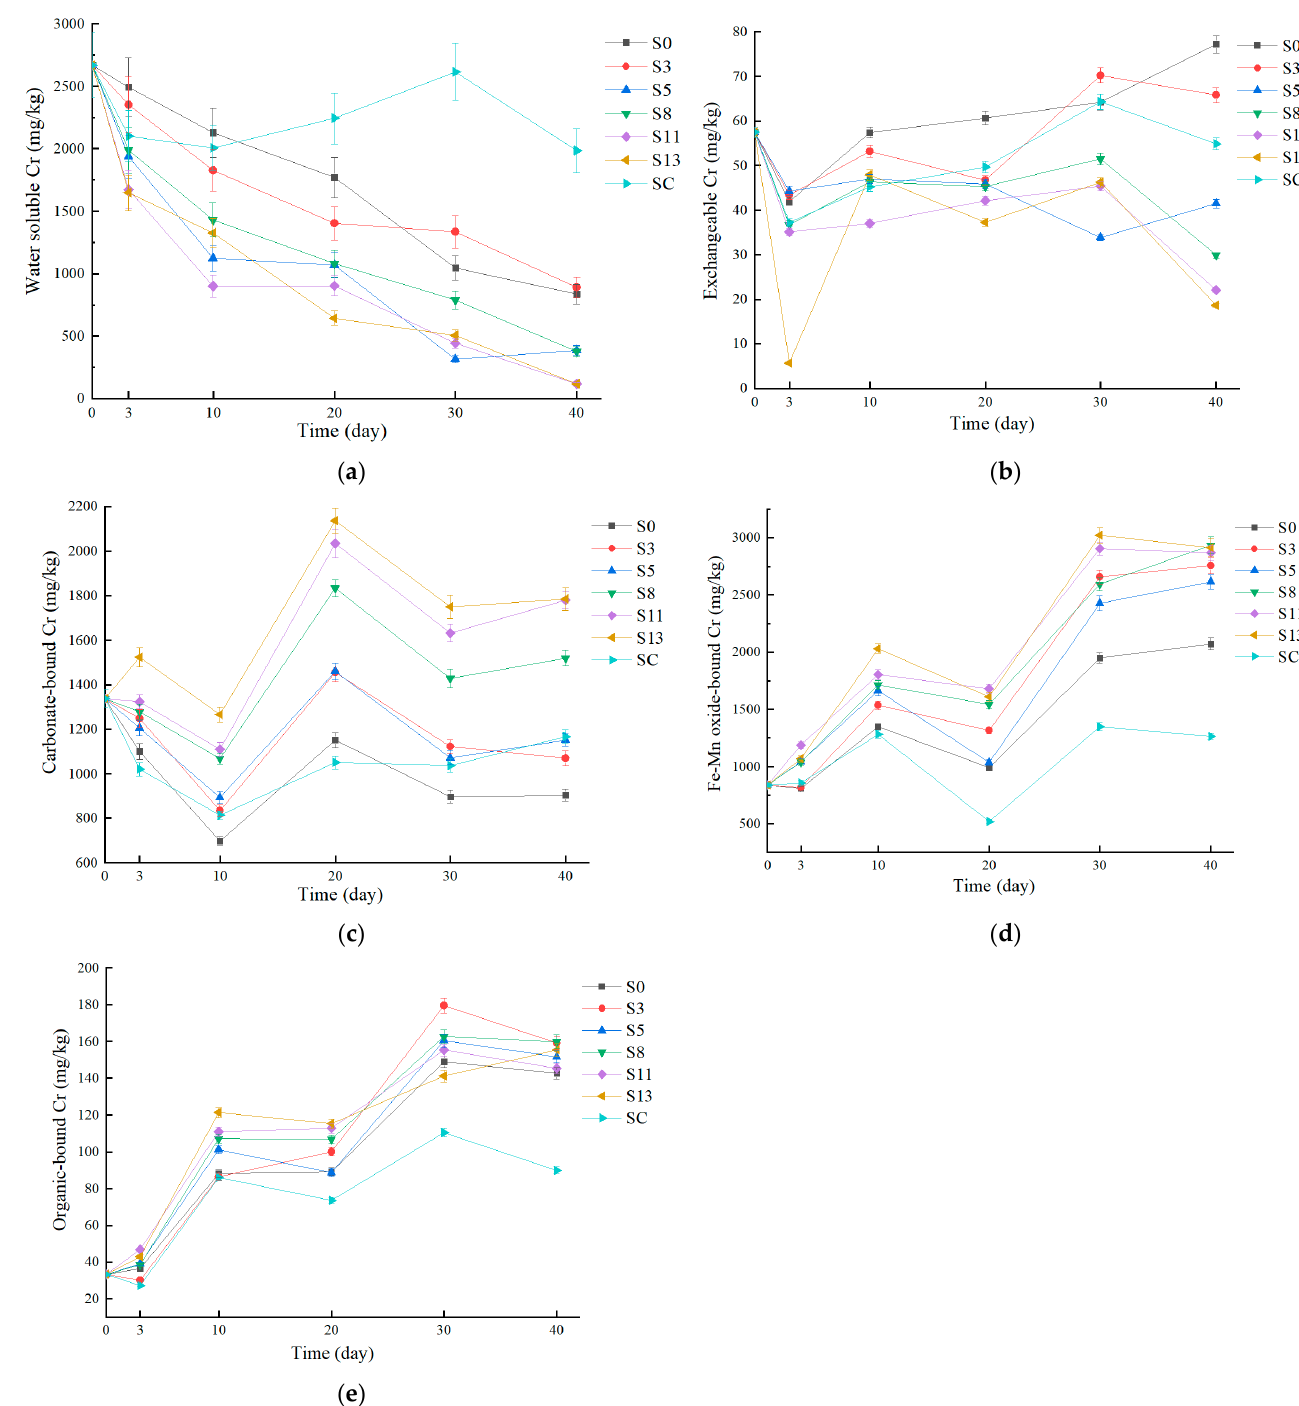
Figure 2. Concentration of Cr speciation in soils during remediation (( a ) water-soluble fraction, ( b ) exchangeable fraction, ( c ) carbonate-bound fraction, ( d ) Fe-Mn oxide-bound, ( e ) organic matter- bound fraction.).